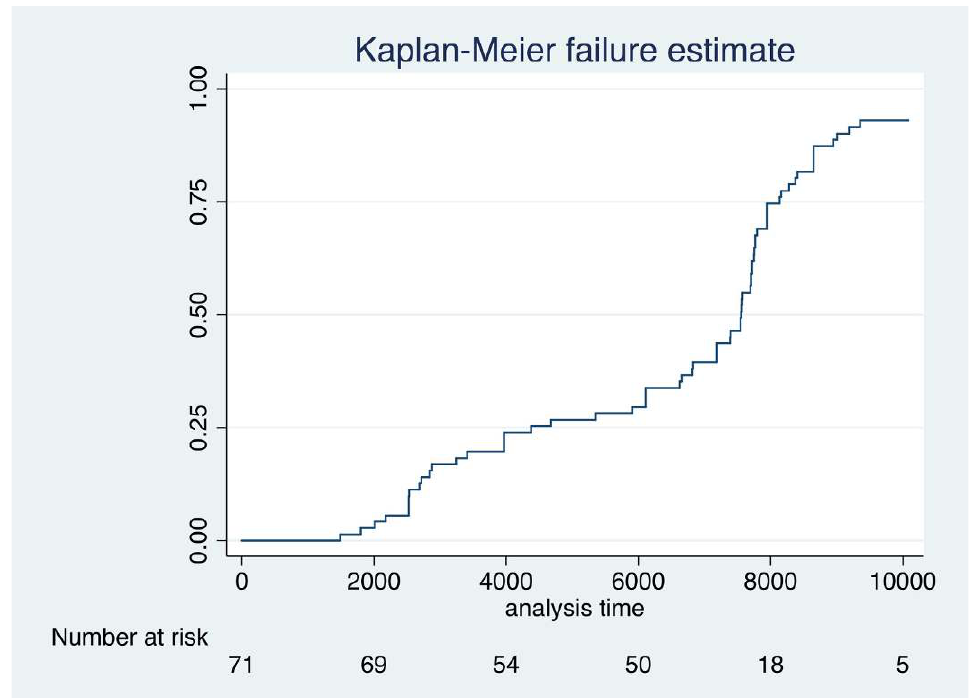
Figure 1: Cumulative distribution of failure times for Metropolitan Regions, Brazil,